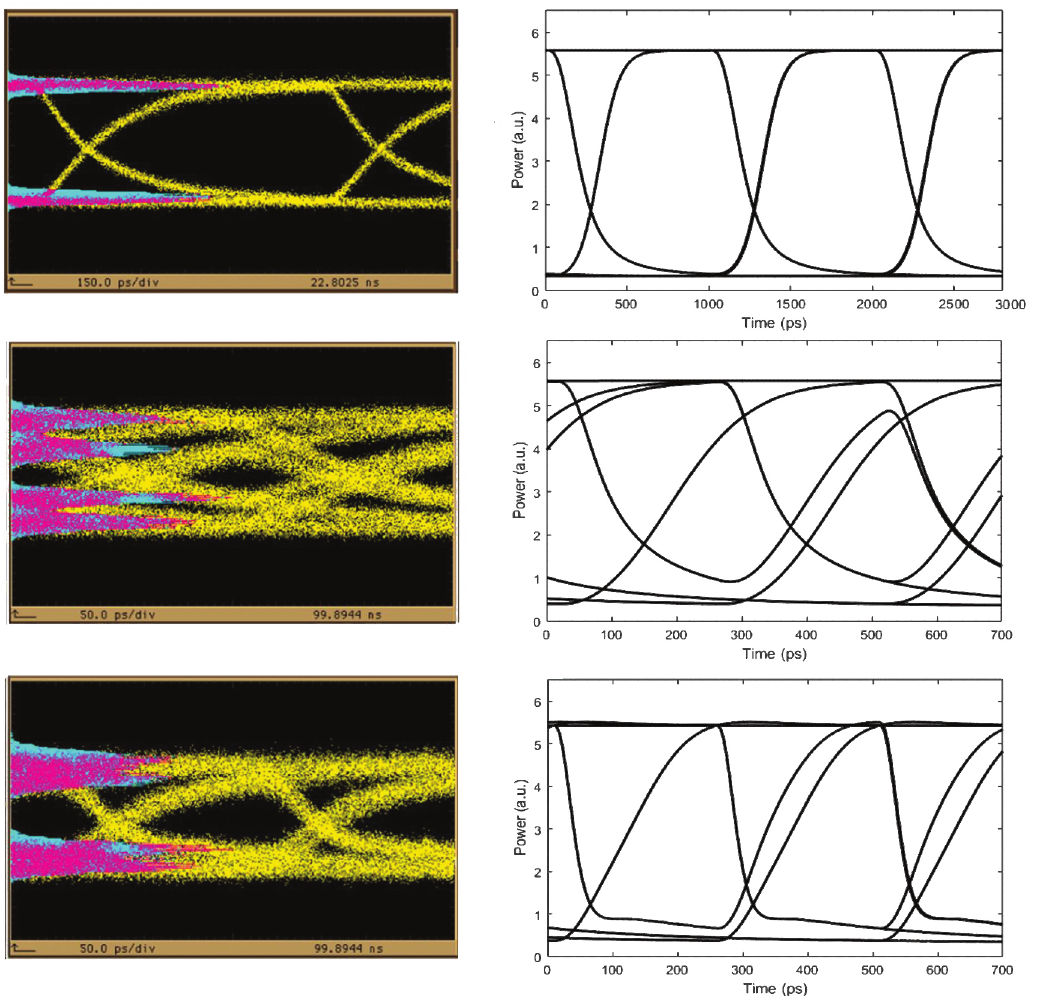
Figure 5. Encoded signals eye diagrams. Upper row : RSOA output at 1 Gb/s. Middle row : RSOA output at 4 Gb/s. Lower row : BFL output at 4 Gb/s. Left column : Experimental results. Right column : Simulation results. Experimental results time scale— Upper row : 150 ps/div; Middle row : 50 ps/div; and Lower row : 50